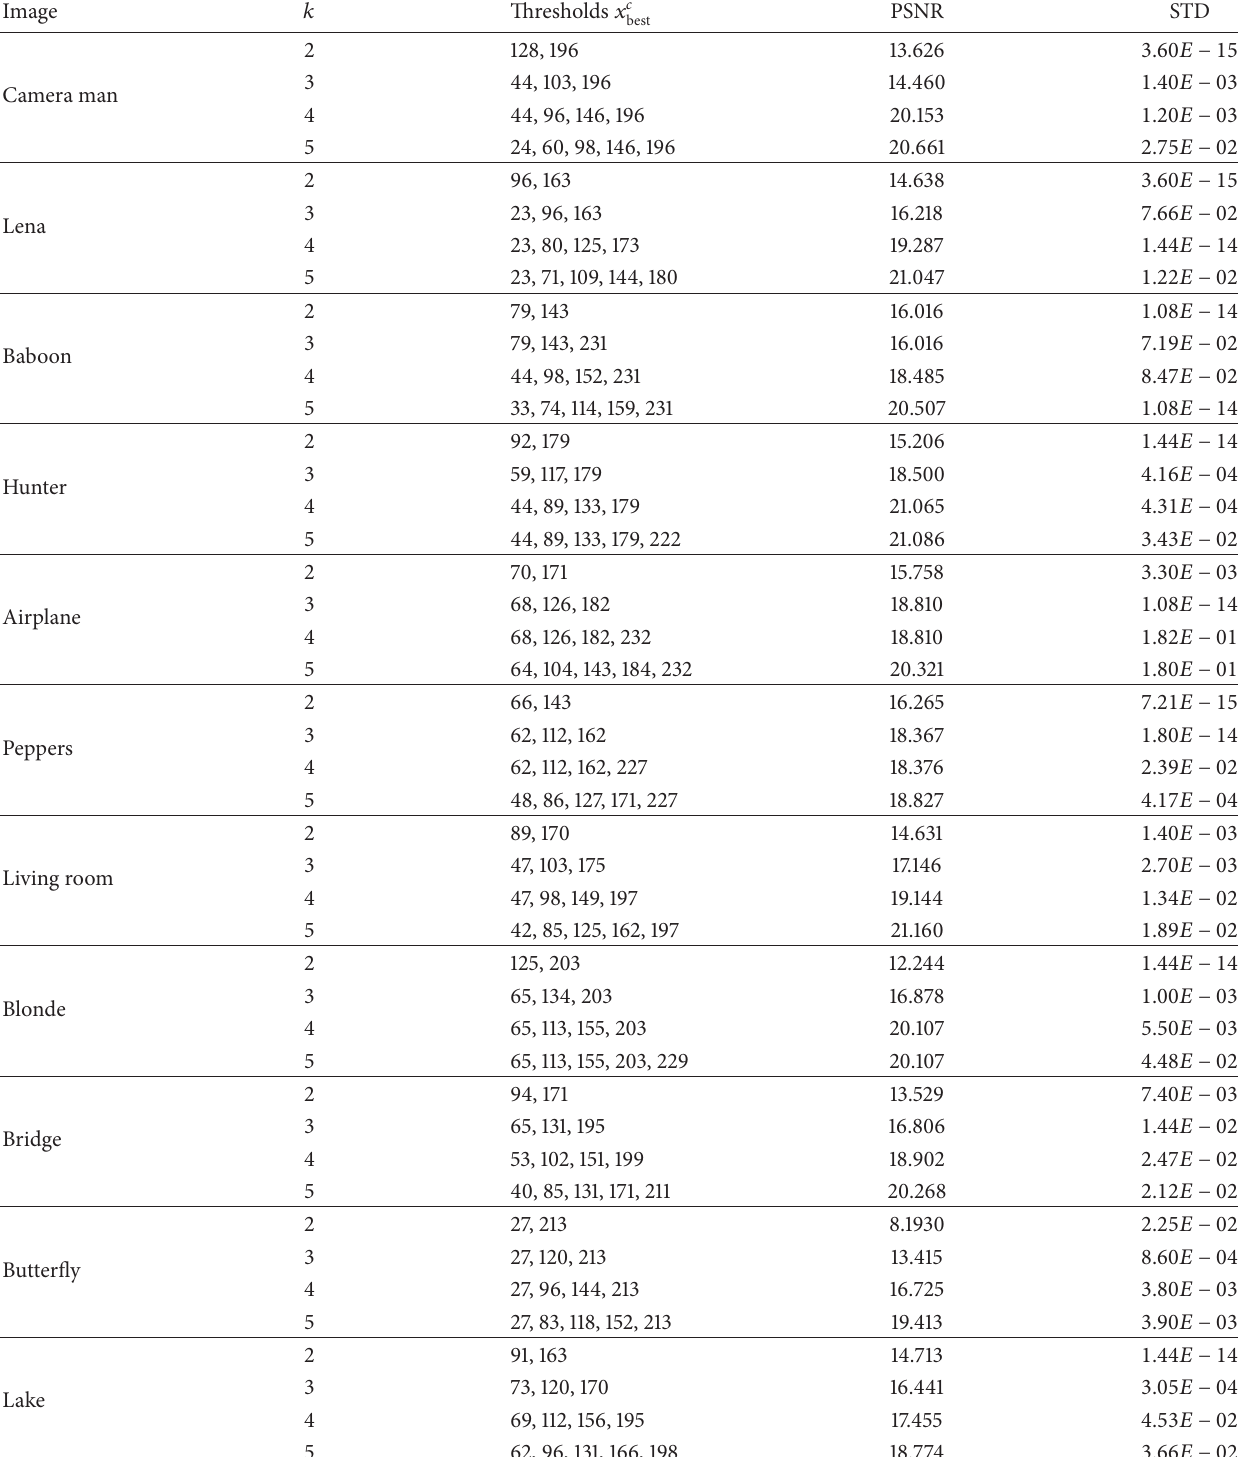
Table 9: Results after appling the HSMA using Kapur’s function to the set of benchmark